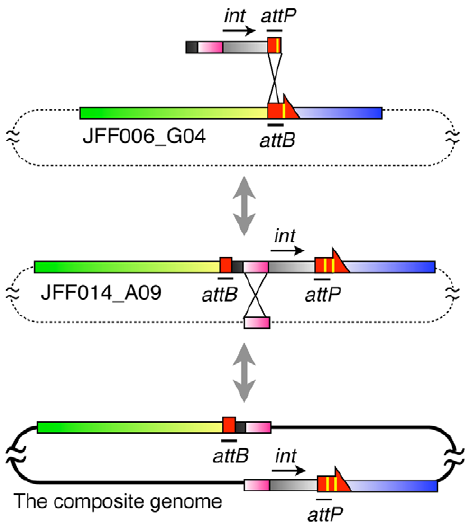
Figure 5. Model explaining the intron gain and fragmentation of the tRNA gene. A model for the intron gain and fragmentation processes of tRNA genes among the heterogeneous C. subterraneum genomes through site-specific recombination of a mobile element and homologous recombination. Dotted lines indicate the genomes of putative heterogeneous C. subterraneum strains. The tRNA Thr gene, a fragment of it, and its intron are denoted by a red arrow, red rectangle, and yellow line, respectively (not to scale). The colors correspond to those in Figure 2. Whereas int represents the integrase gene, attP and attB denote the attachment sites for integration.